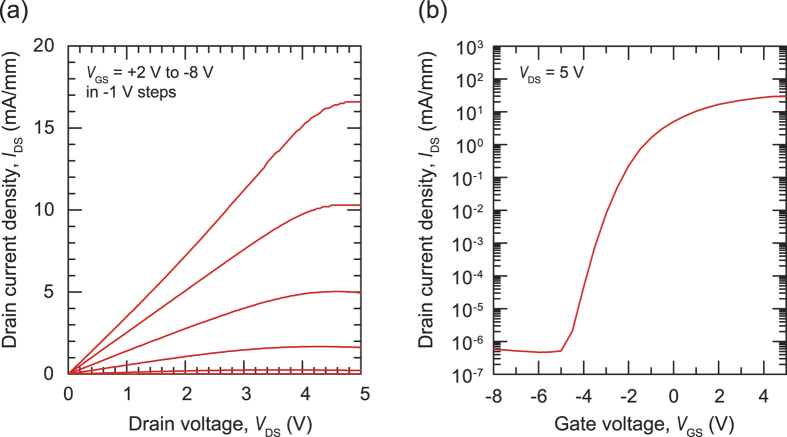
(a) Output and (b) transfer characteristics of an In0.45Ga0.55N thin-film transistor.